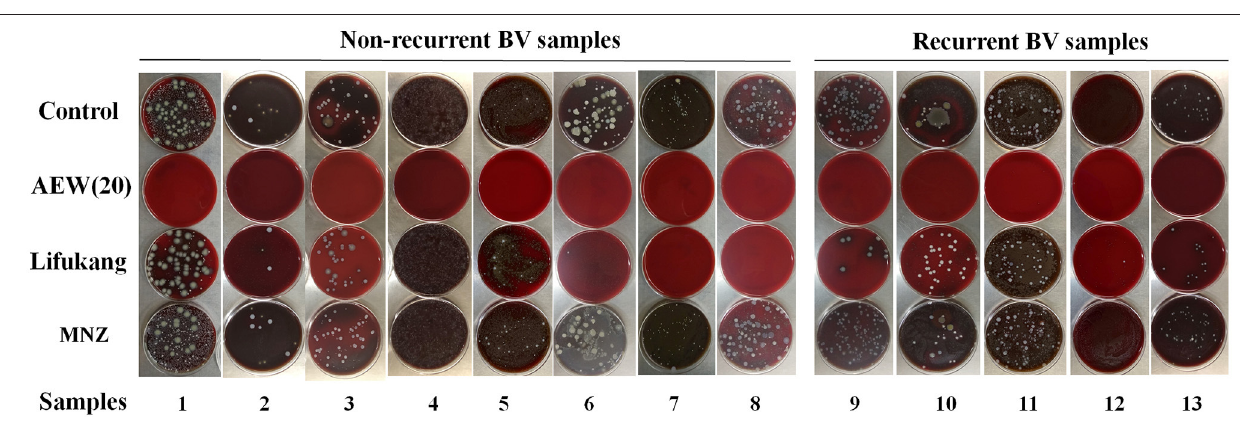
FIGURE 5 | Twenty ppm AEW significantly inhibited the microbial viability of vaginal secretions of BV patients. The picture showed the bacterial growth of the vaginal secretions of BV patients after 20 ppm AEW, Lifukang, and MNZ